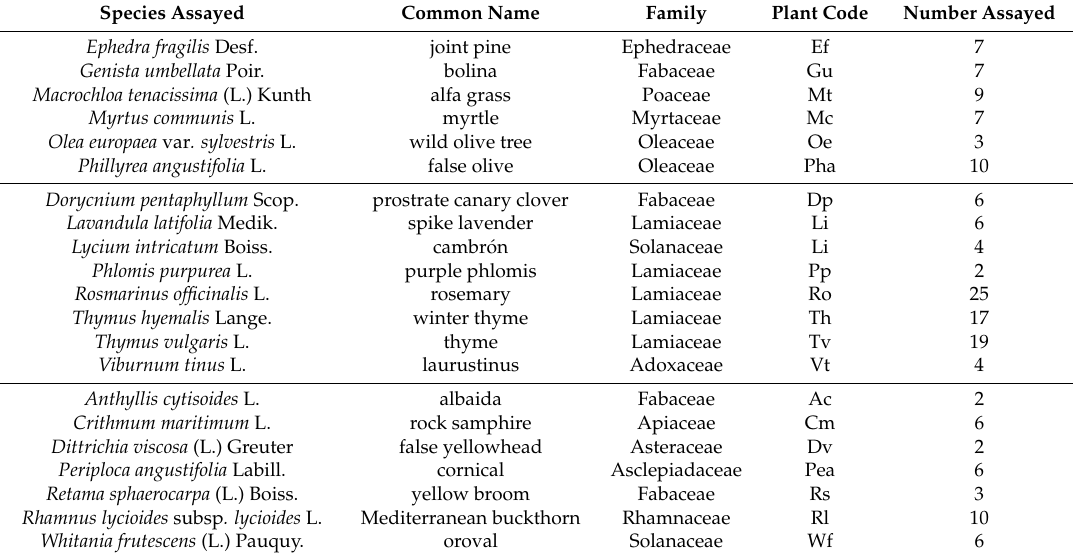
Table 1. Native shrub species selected for habitat management in Mediterranean greenhouse areas. Species